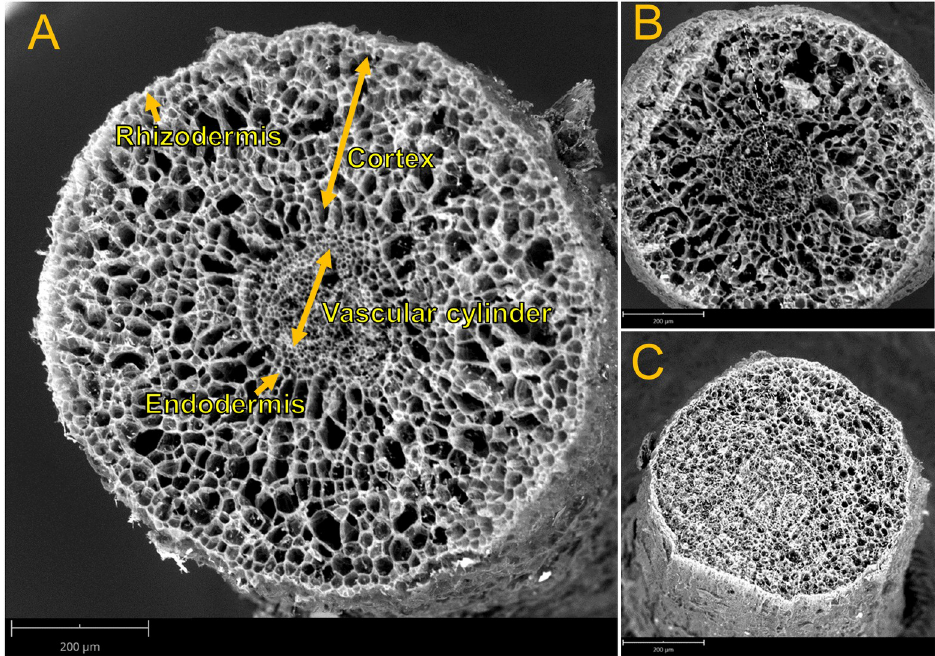
Fig 5. SEM imaging of P . × canescens root. Cross section (A) showing different cell layers in root. Sections of root from 100 mM NaCl treated plant (B) as well as control plant (C) are presented. Bars = 200 μ m.